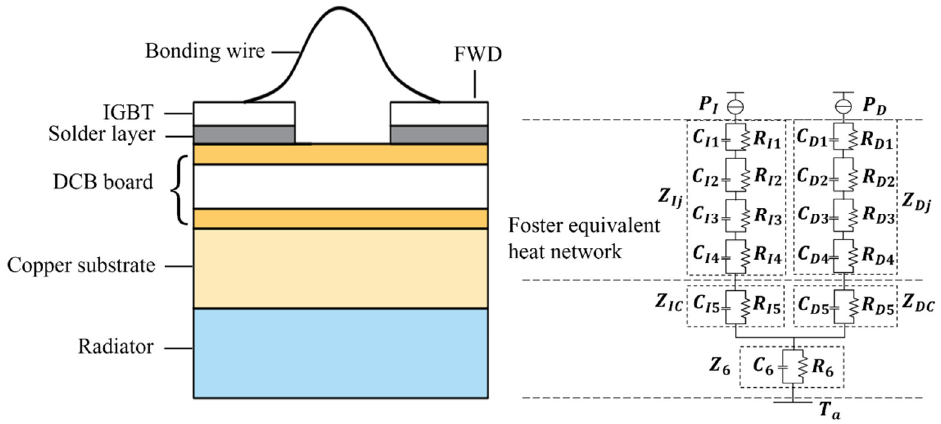
Figure 1. Heat network model.